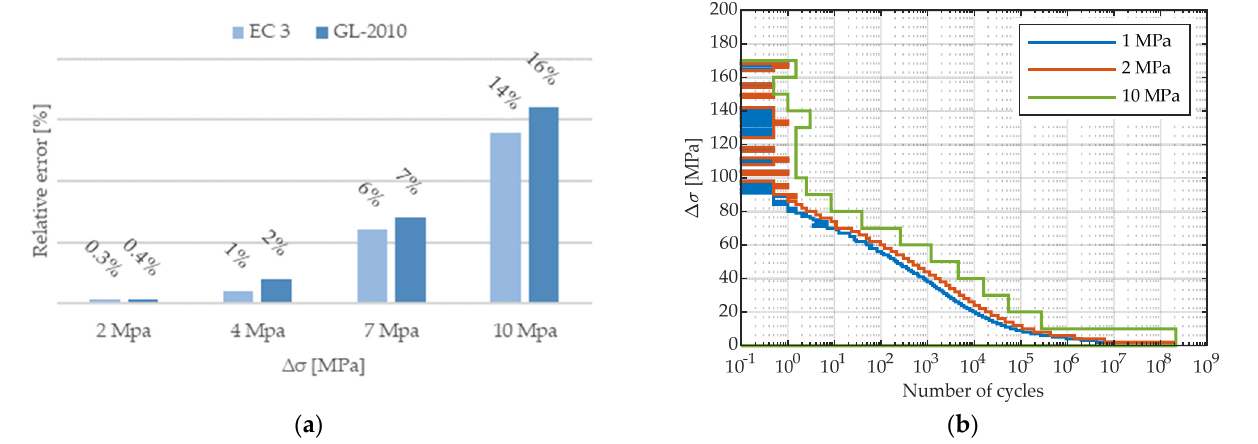
Figure 13. Influence of the rainflow histogram resolution: ( a ) relative difference of the calculated damage (the 1 MPa bin amplitude is the reference); and ( b ) stress cycles histogram.